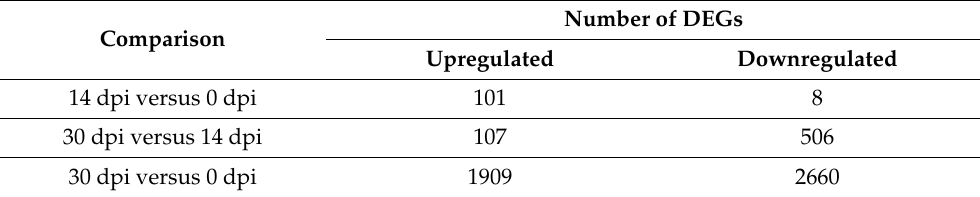
Table 1. Numbers of differentially expressed genes in the leave transcriptomes.